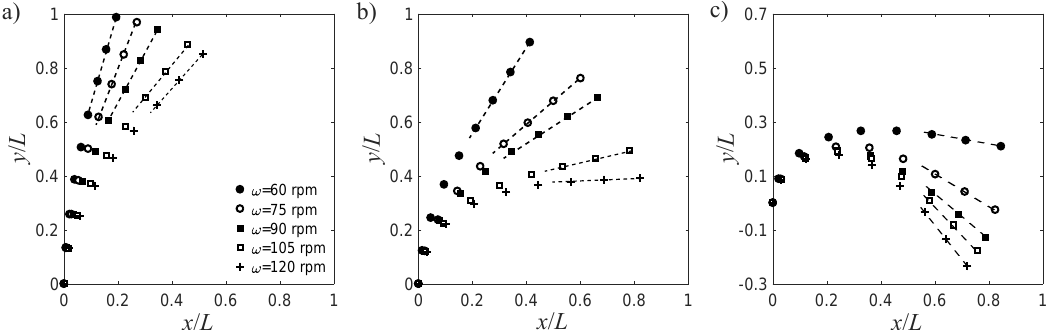
Figure 2. Mean deformation of the: ( a ) thick; ( b ) medium; and ( c ) thin plates for various rotational speeds. Dashed lines indicate the section of the plates with negligible deformation.